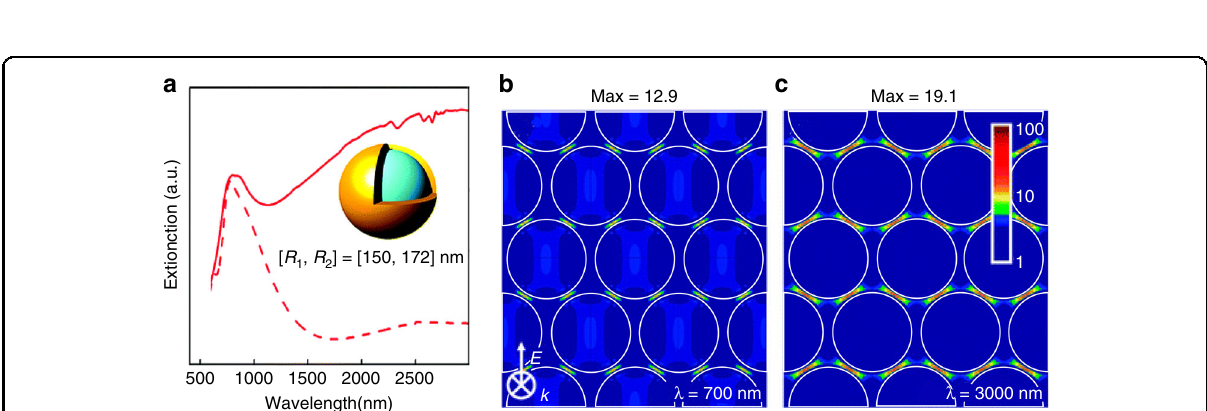
Fig. 6 Multi-nanoparticles for SERS and SEIRA. a Extinction spectra of a typical hexagonal close-packed (hcp) Au nanoshell array (solid line) and that of an isolated nanoshell with the same size (dashed line). The inner radius of the core is 150 nm and the thickness of the gold shell is 22 nm. The separation between adjacent nanoshells is 8 nm. b and c The local electromagnetic fi eld enhancements of an HCP Au nanoshell array at wavelengths of 700 and 3000 nm, respectively 65 . Reproduced a – c with permission from ref. 65 . Copyright (2008) American Chemical Society